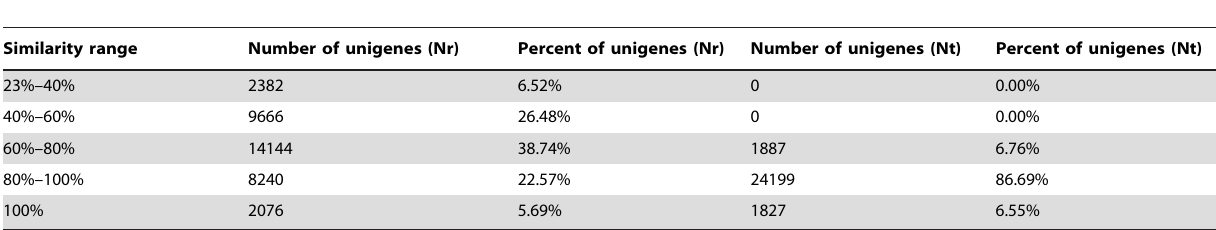
doi:10.1371/journal.pone.0090636.t004